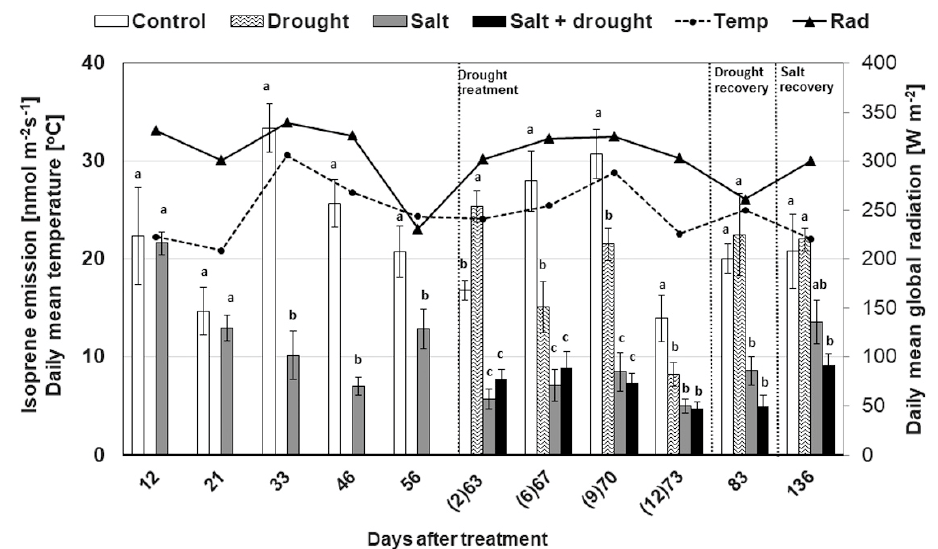
Figure 6. Effect of drought, salt, and the combination of both stresses on isoprene emission in sweetgum plants. Values are mean ± SE ( n = 10). Data characterized by the same letter do not differ significantly ( p < 0.05).